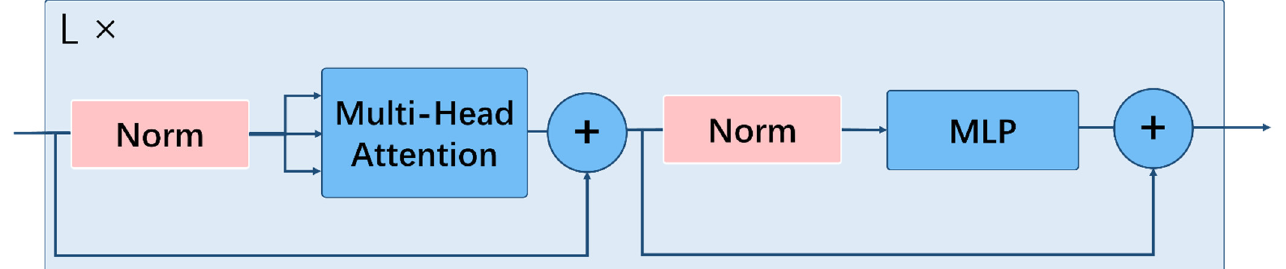
Figure 5. Structure of the Transformer Encoder in the attention block.